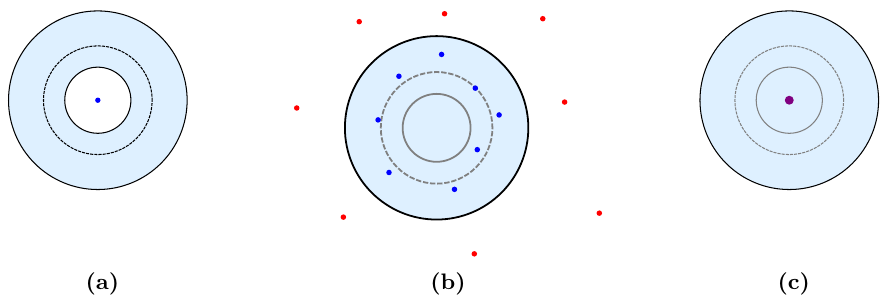
Figure 2 . Positions of CFT vertex operators in the complex v -plane. (a) Heavy primary, shown as a blue dot, in the origin. Only the shaded blue region is mapped to the region in spacetime between the conformal boundaries (the solid circles). The dotted circle maps to the horizon. (b) Collection of light primaries within the unit disk (blue dots), and in image points (red dots), which is expected to map to a capped geometry in the bulk. (c) From the CFT point of view the previous con(cid:12)guration is equivalent to inserting a highly non-primary operator in the origin (purple